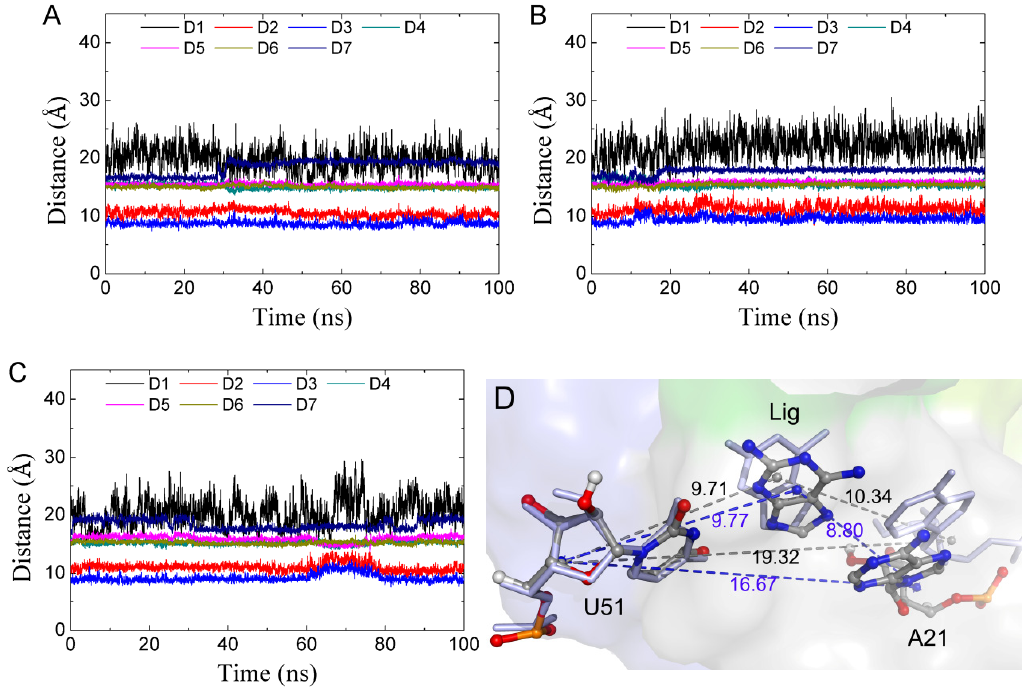
Figure 7. The key distances described in Figure 6 versus MD simulation time. ( A ) Closed state. ( B ) Conformational change at the start of the MD simulation. ( C ) Open state in the middle of the MD simulation. ( D ) The position of A21 for two representative structures of D7. Table 3. The percentages of conformational states and the distances